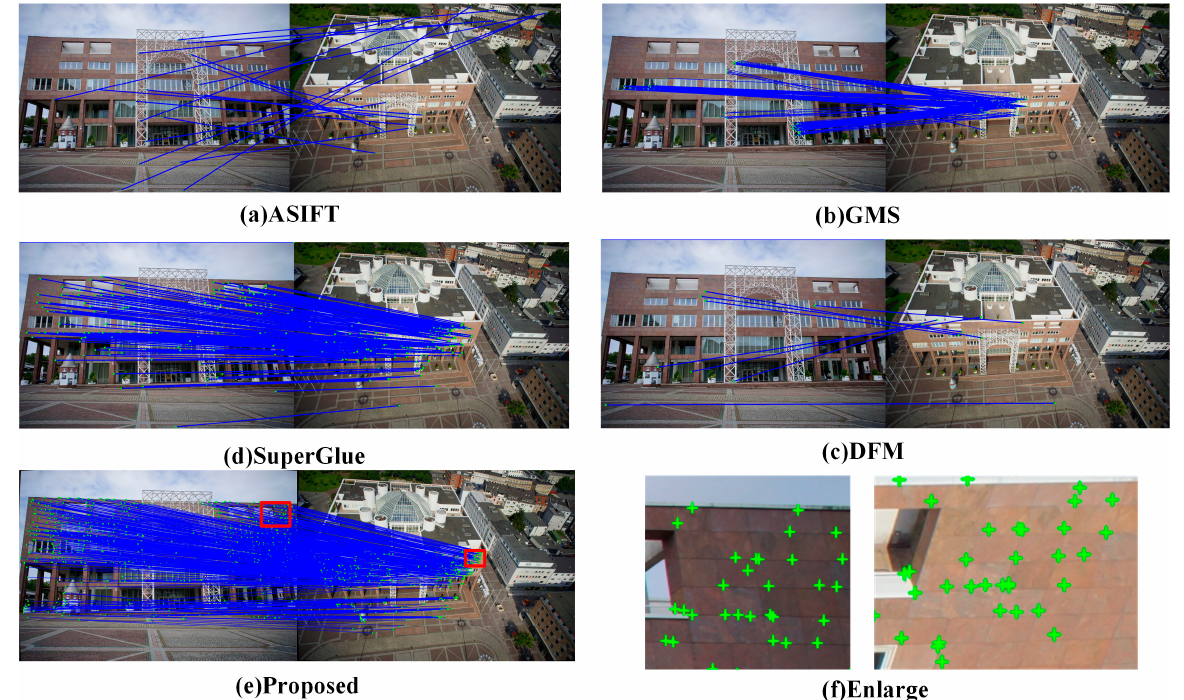
Figure 13. Image feature-matching comparison on the Dortmund (Center) dataset. ( a – e ) show the matching results of the ASIFT, GMS, DFM, and SuperGlue algorithms, respectively. ( e ) shows the matching result of the proposed algorithm, and ( f ) shows a magnified view of the matched feature points. Table 3. Quantitative results of the different methods on dataset Dort-CENTER.